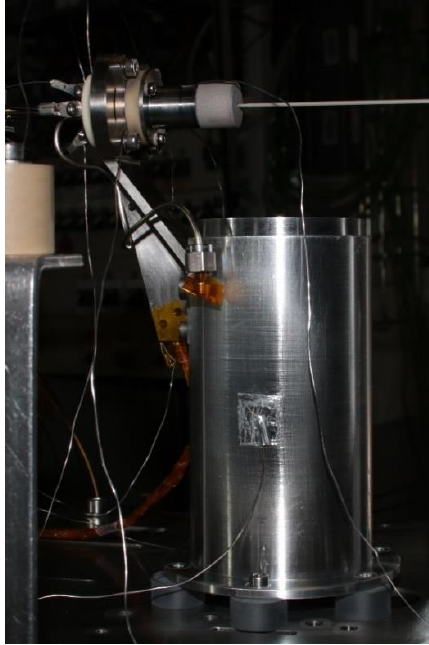
Figure 5. Cathode mounted with dedicated bracket on a thruster dummy model for the thermal test.